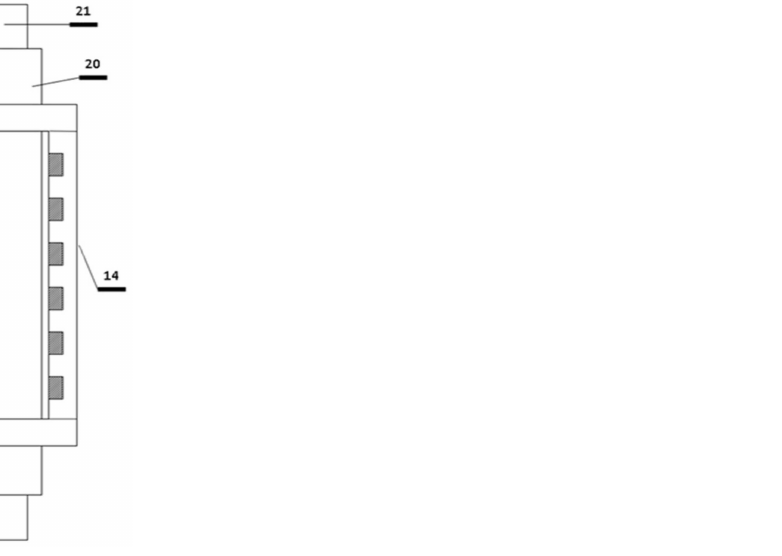
Figure 9. The solidification channel (“21”) equipped with a heating and cooling mantle (“20”).